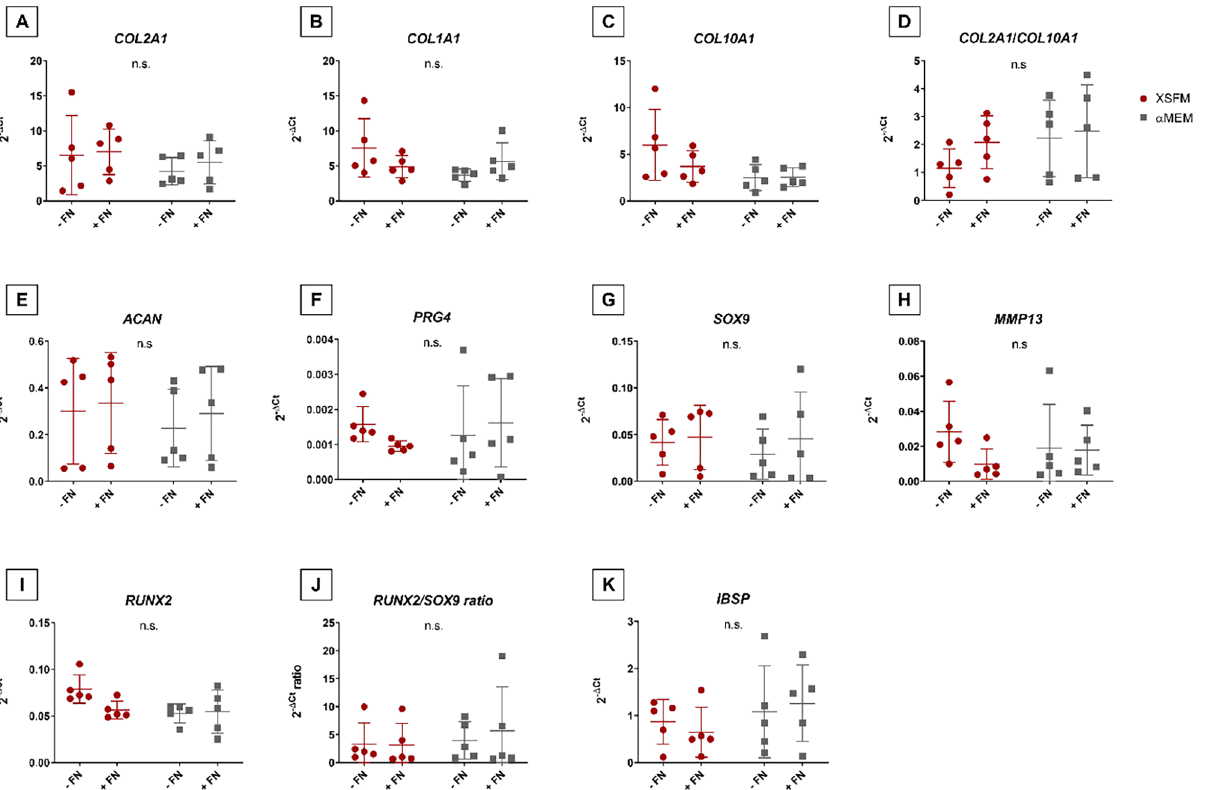
Figure 7. Culture conditions during monolayer expansion of BMSCs modulate differently the expression of chondrogenic markers during differentiation. After expansion in either αMEM/FBS/FGF2 or XSFM (with or without fibronectin coating), cells were cultured for 21 days in chondrogenic medium containing 10 ng/ ml of TGF-β1. The expression of ( A ) COL2A1 , ( B ) COL1A1 , ( C ) COL10A1 , ( D ) COL2A1 / COL10A1 ratio, ( E ) ACAN , ( F ) PRG4 , ( G ) SOX9 , ( H ) MMP13, ( I ) RUNX2, ( J ) RUNX2/SOX9 ratio and ( K ) IBSP were normalized to ribosomal protein large, P0 ( RPLP0 ). The gene expression levels are represented as 2 (-ΔCt) (mean ± SD; n = 5). Grey bars represent scatterplot of different donor measurements in BMSC cultured in αMEM, red bars represent scatterplot of different measurements in BMSC cultured in XSFM medium, FN is the presence ( +) or absence (−) fibronectin coating during the BMSC expansion. Data are expressed as mean ±